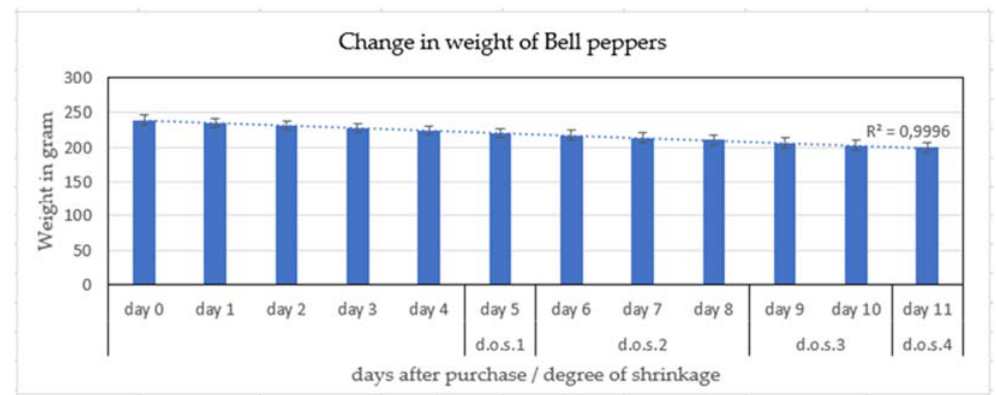
Figure 5. Weight loss of bell pepper fruit stored for 14 days averaged over all three fruit colors and